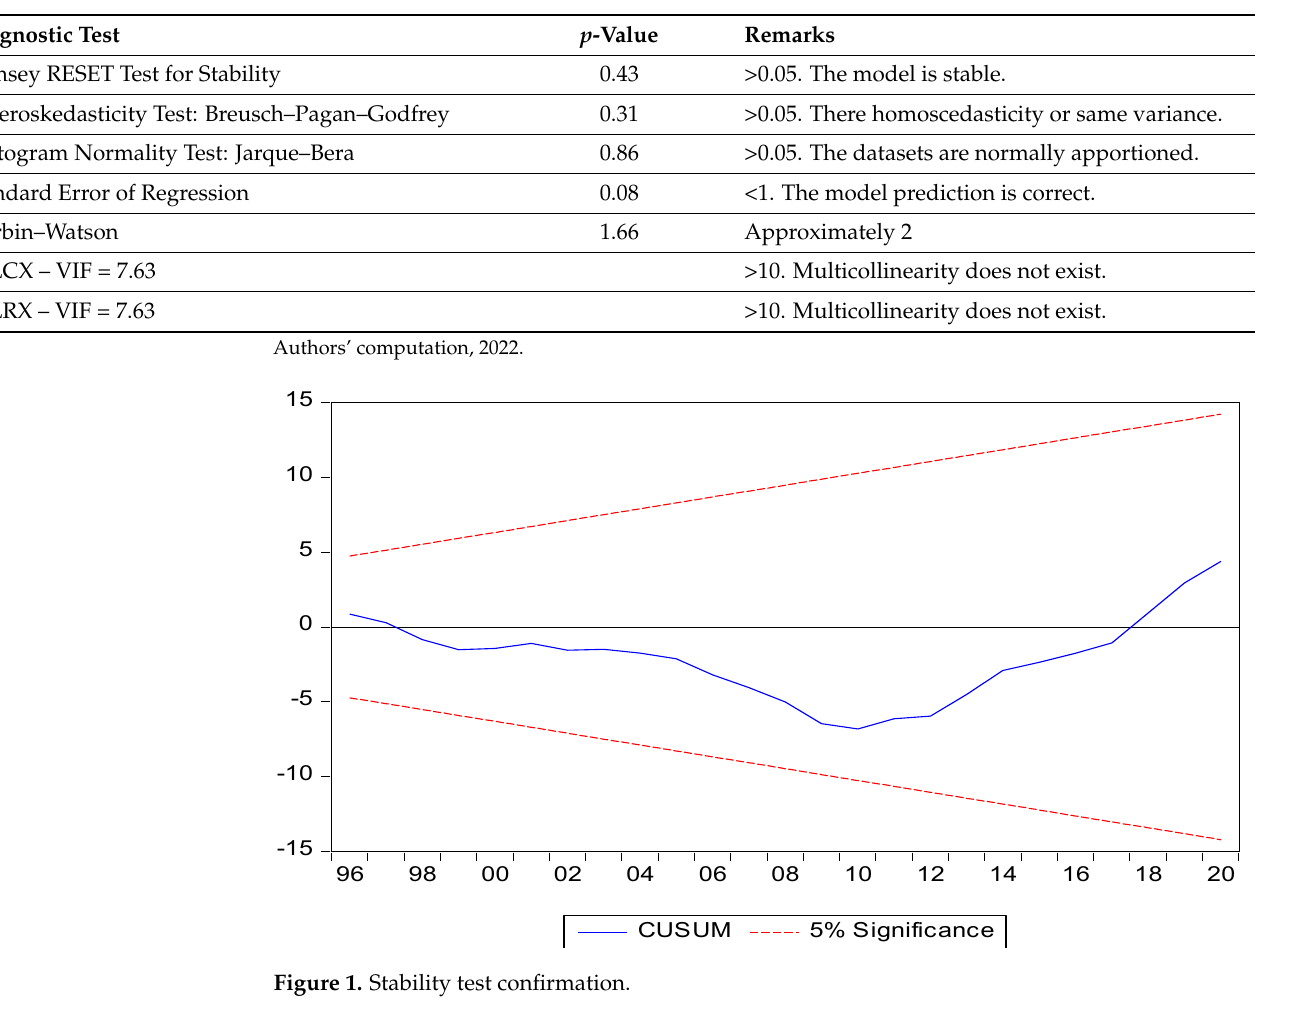
Table 3. Analytical checks.